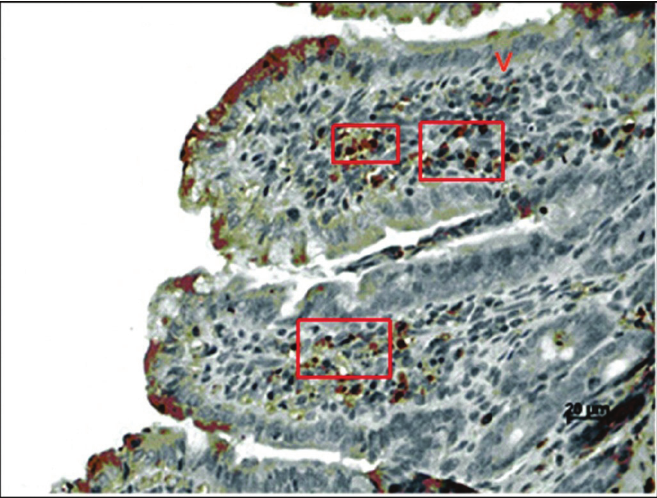
FIGURE 7 - Immunohistochemical aspect of caspase-3 in the HBO/I-R/ HBO group. V - villosity,- caspase-3 markers